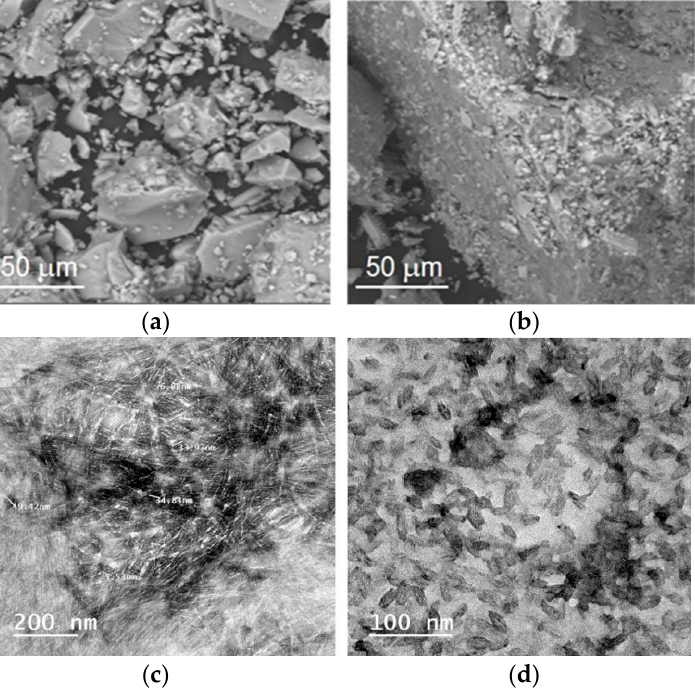
Figure 3. FE ‐ SEM images of ( a ) TiO 2 , ( b ) NC20–TiO 2 , and TEM images of ( c ) NC and ( d ) NC20–TiO 2 .